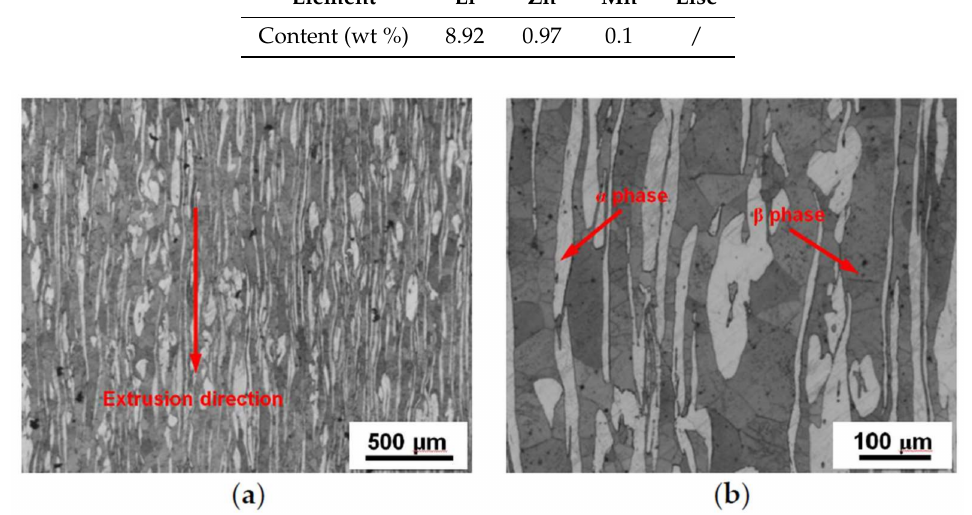
Figure 1. OM images of the as-received LZ91 alloy at ( a ) 50 × , and ( b ) 200 ×